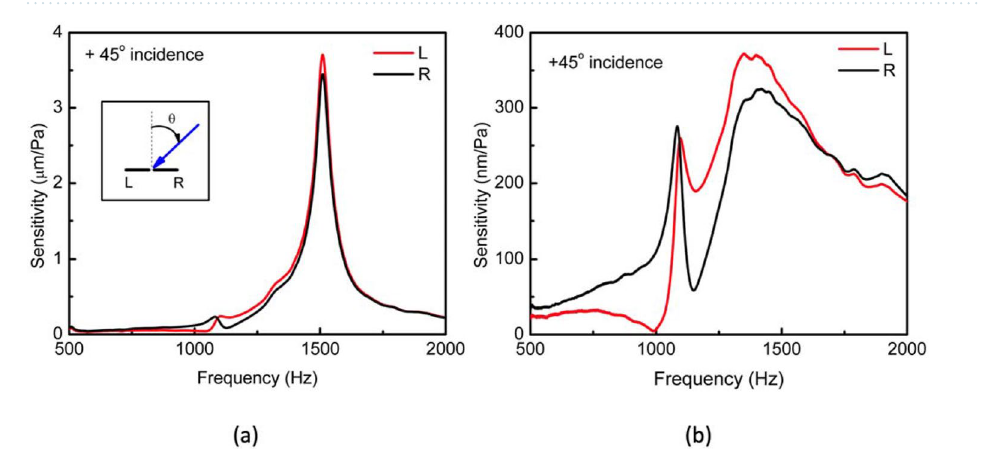
Figure 3. Sensor mechanical frequency response. Under excitation of a sound wave at oblique incidence with respect to the sensor, the frequency responses of the wings displacement per unit sound pressure level [ m · Pa − 1 ] were measured ( a ) before closing the back cavity and ( b ) after attaching the backplate, closing the cavity. Inset in ( a ) displays the adopted reference system and nomenclature: angles are measured positive in the clockwise sense from the normal of the sensor. Left (L) and right (R) orientation are defined for an observer placed at the sensor, facing the sound